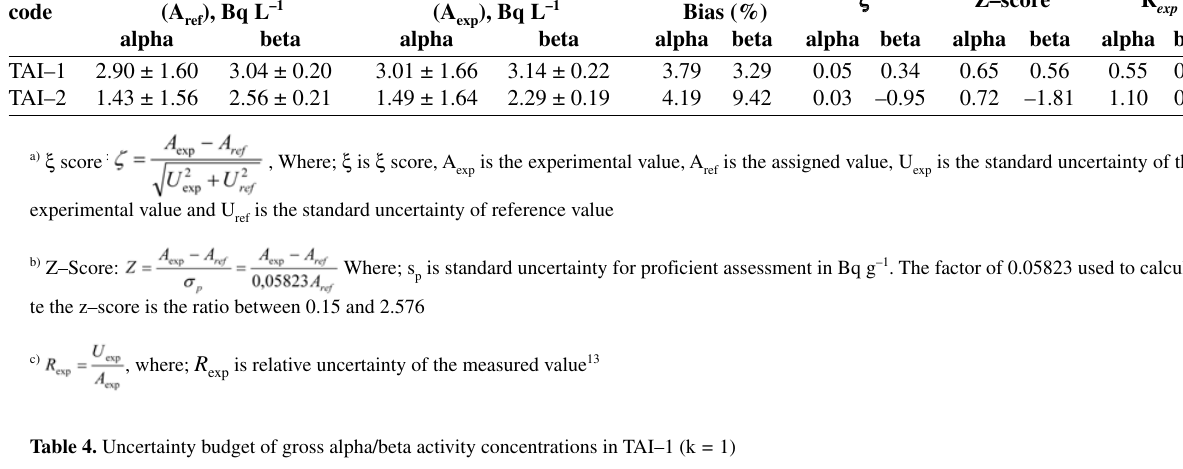
Table 4. Uncertainty budget of gross alpha/beta activity concentrations in TAI–1 (k = 1) Uncertainty component Counting statistic (including